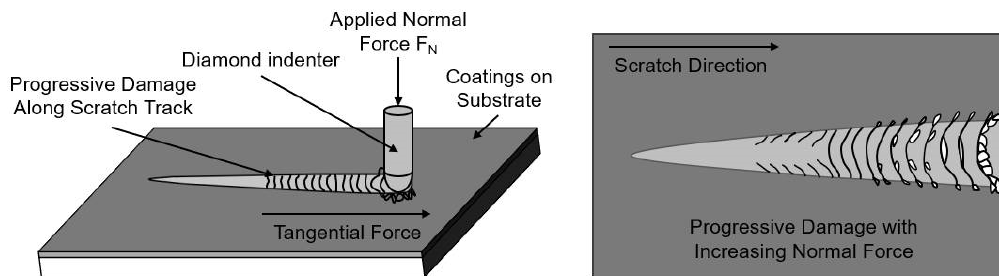
Figure 2. Diagram of coatings fracture.